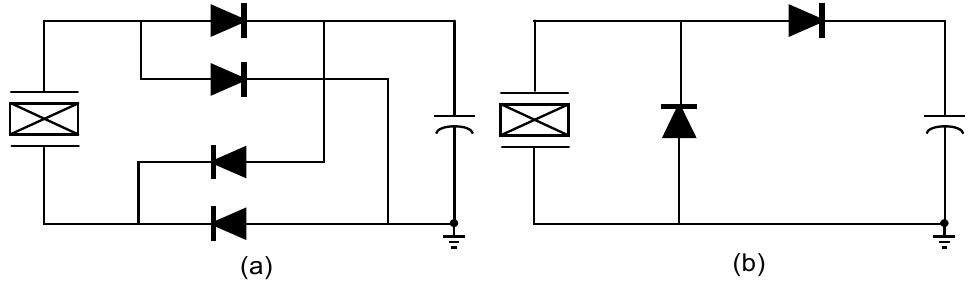
Figure 6. Structure diagrams of ( a ) full bridge rectifier and ( b ) voltage doubler.